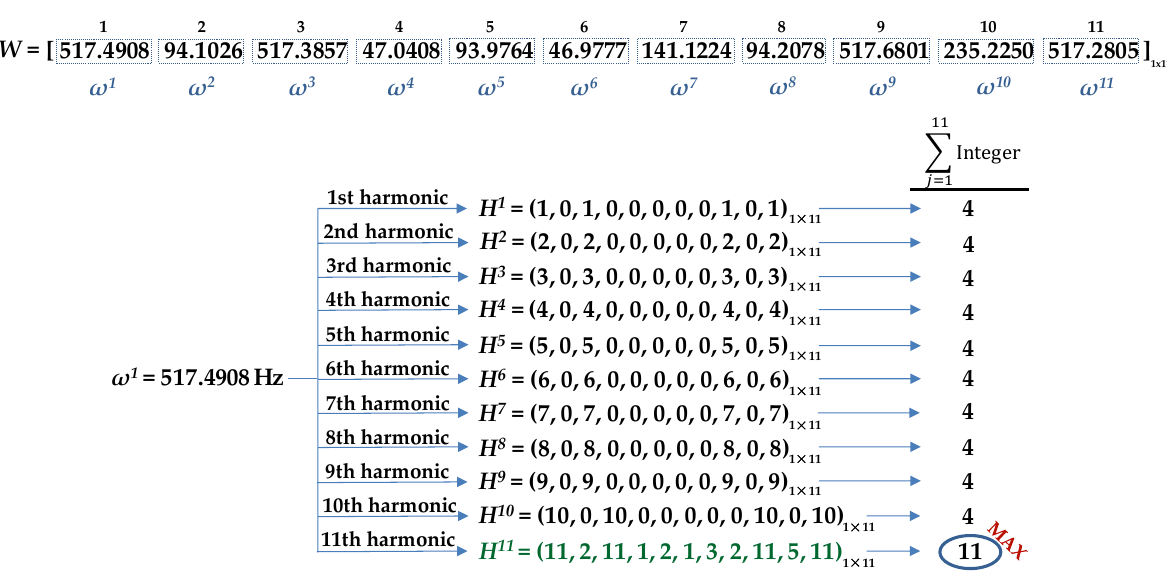
Figure 5. Row vector of peak frequencies, W , normalized frequency row vectors, H k and counting of the non-null elements obtained for all possible harmonic orders of the first element, ω 1 .